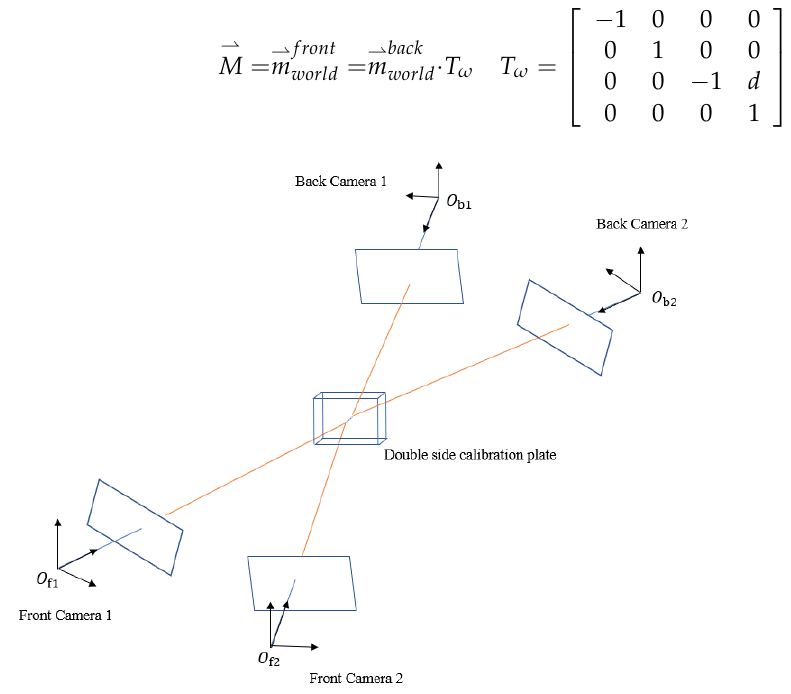
Figure 3. Schematic of double-sided calibration strategy.